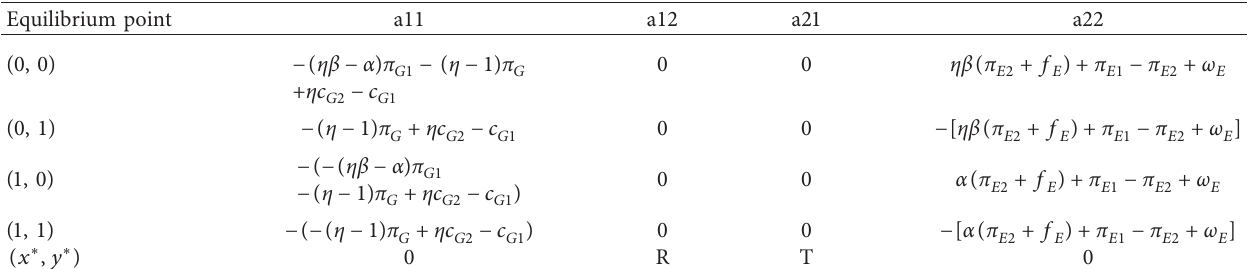
Table 2: Value table of each parameter in partial equalization.